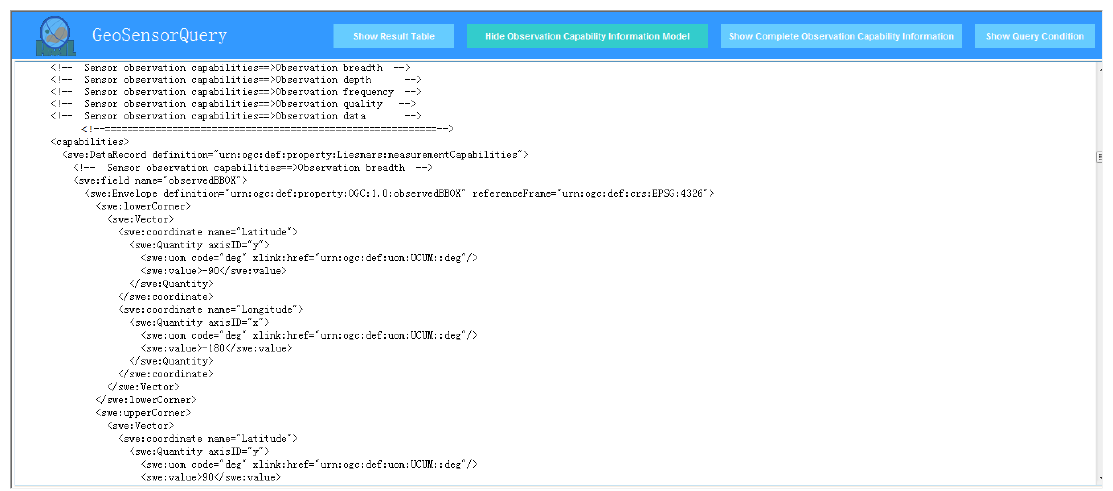
Figure 10. SensorML 1.0-based information model.